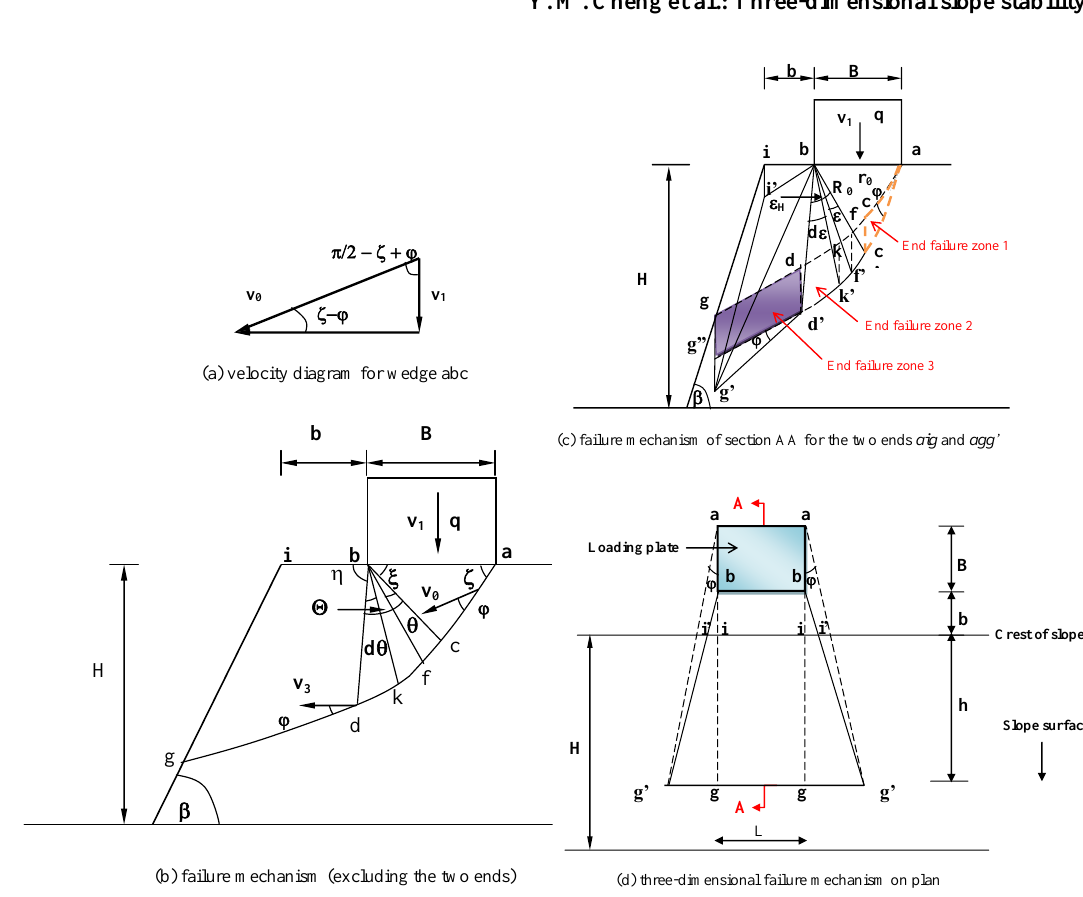
Figure 1. Three-dimensional failure mechanism for slope problem with a patch load.